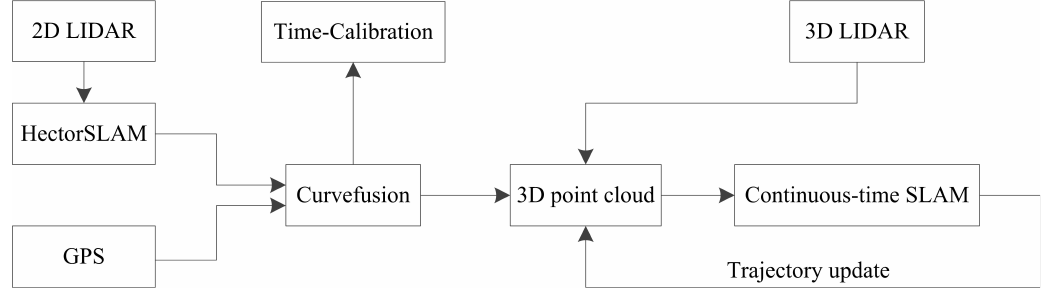
Figure 2. Overview of the proposed system